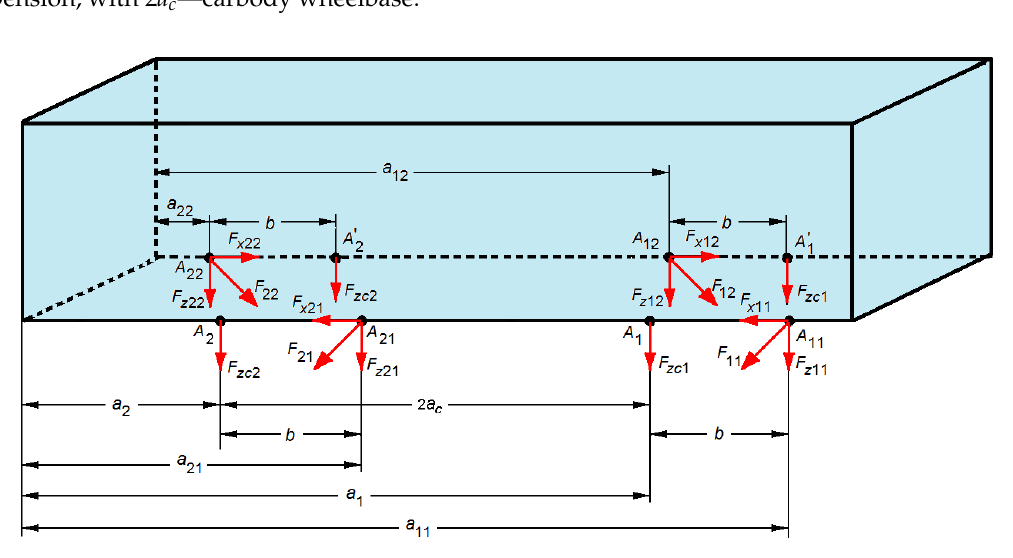
Figure 2. Forces acting upon the carbody.